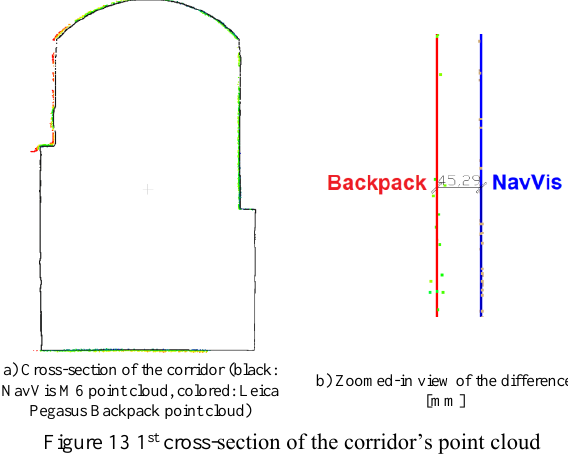
Figure 12 Selected cross sections on the long corridor